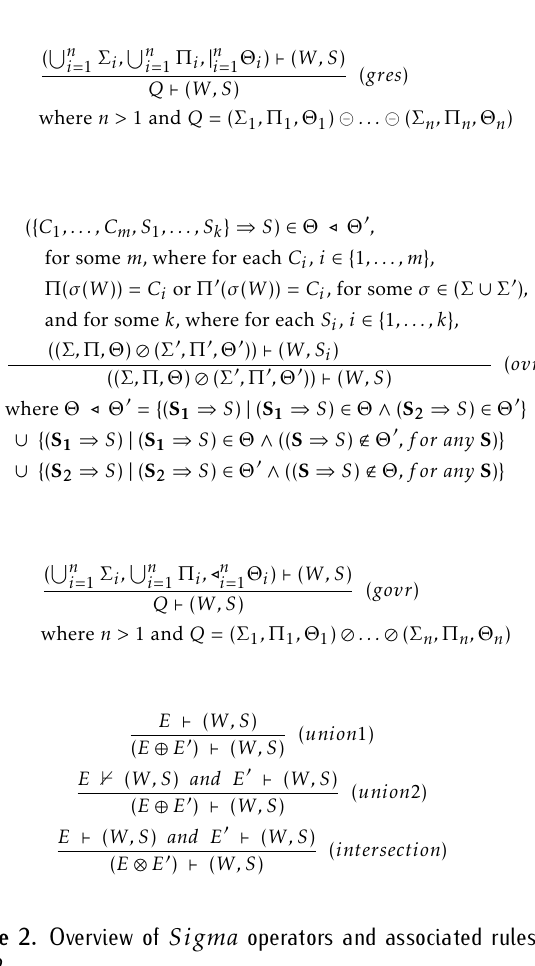
Figure 2. Overview of Sigma operators and associated rules - part